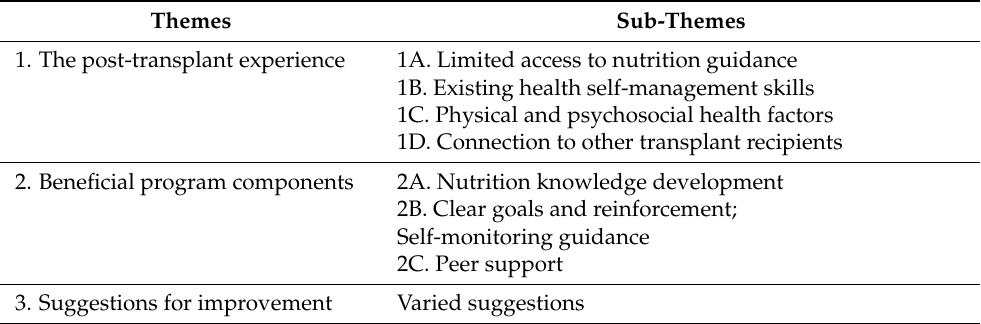
Table 1. Themes and sub-themes in both intervention groups (Tx-GLB and Tx-GLB + Ngx) 1